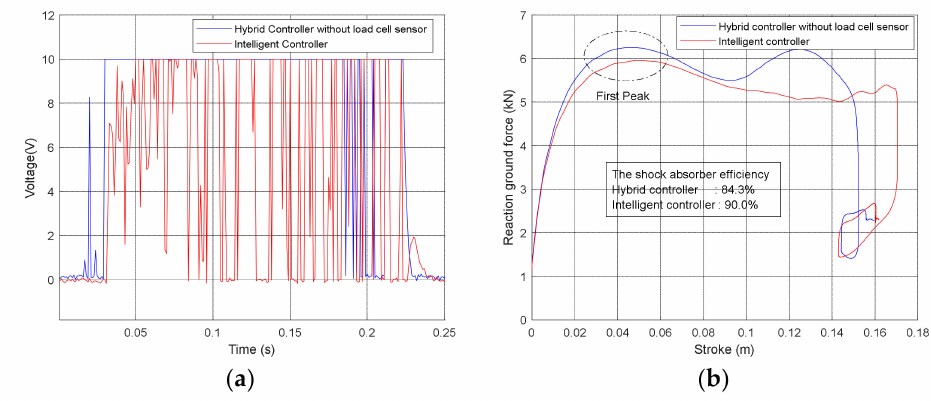
Figure 15. ( a ) Voltage applied to MR core, ( b ) efficiency curve. The performance of the landing gear using the hybrid controller without exact data and intelligent controller in the case of m 1 = 210 kg, v = 2 m/s.